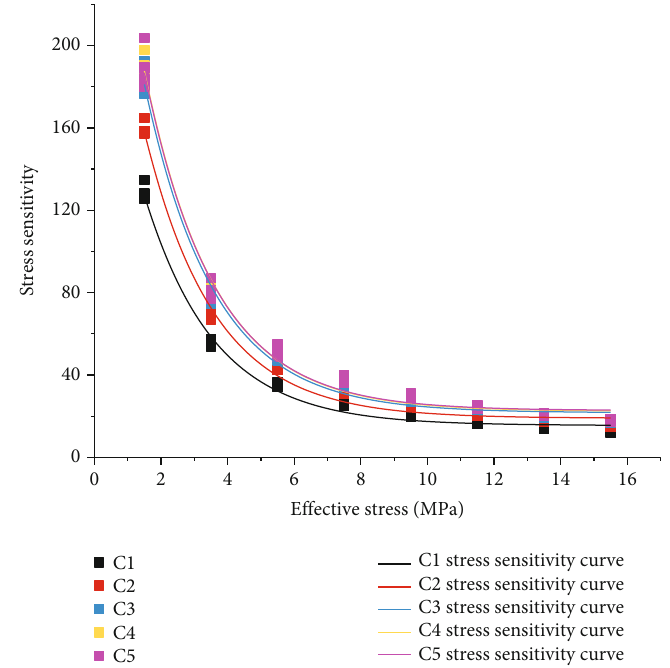
Figure 14: Comparison of sensitivity curves of fi ve broken